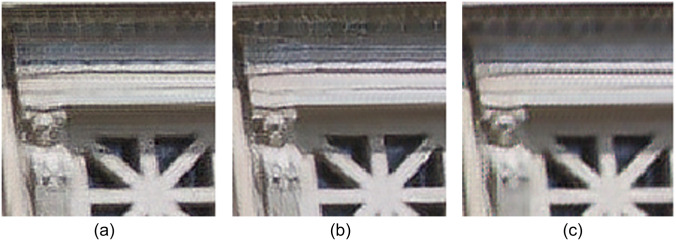
The impact of IQA network’s status on the training of the SR network in vision.(a) is the result of 0812.png in DIV2K dataset using the 1st set of hyper-parameters, (b) is the result of 0812.png in DIV2K dataset using the 2nd set of hyper-parameters, (c) is the result of 0812.png in DIV2K dataset using the 3rd set of hyper-parameters.